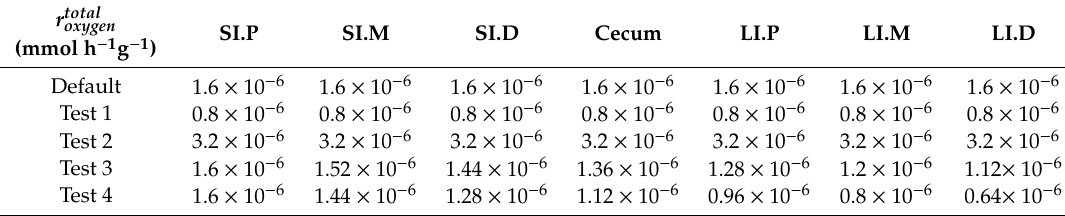
Table 3. Sets of values tested for the total oxygen available r total oxygen .